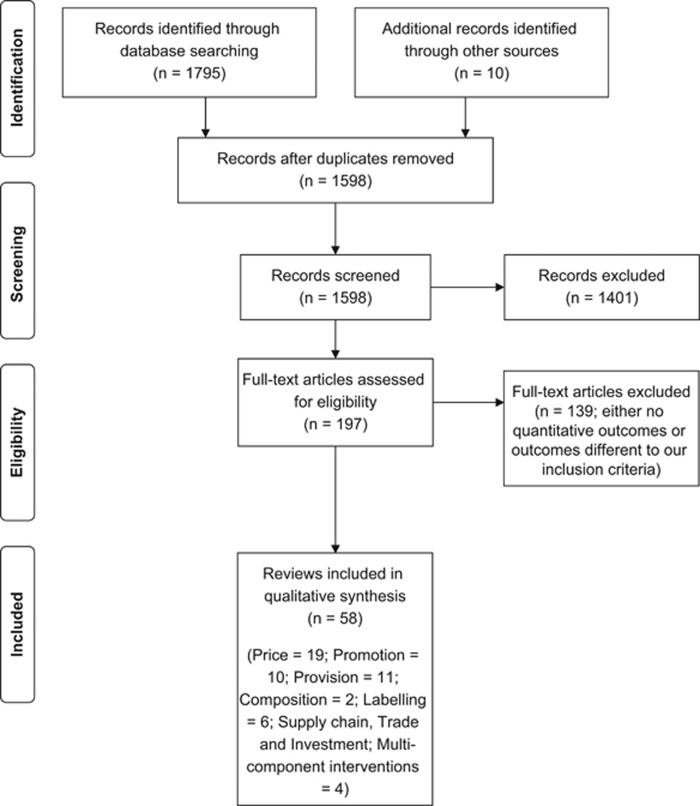
PRISMA flow diagram.